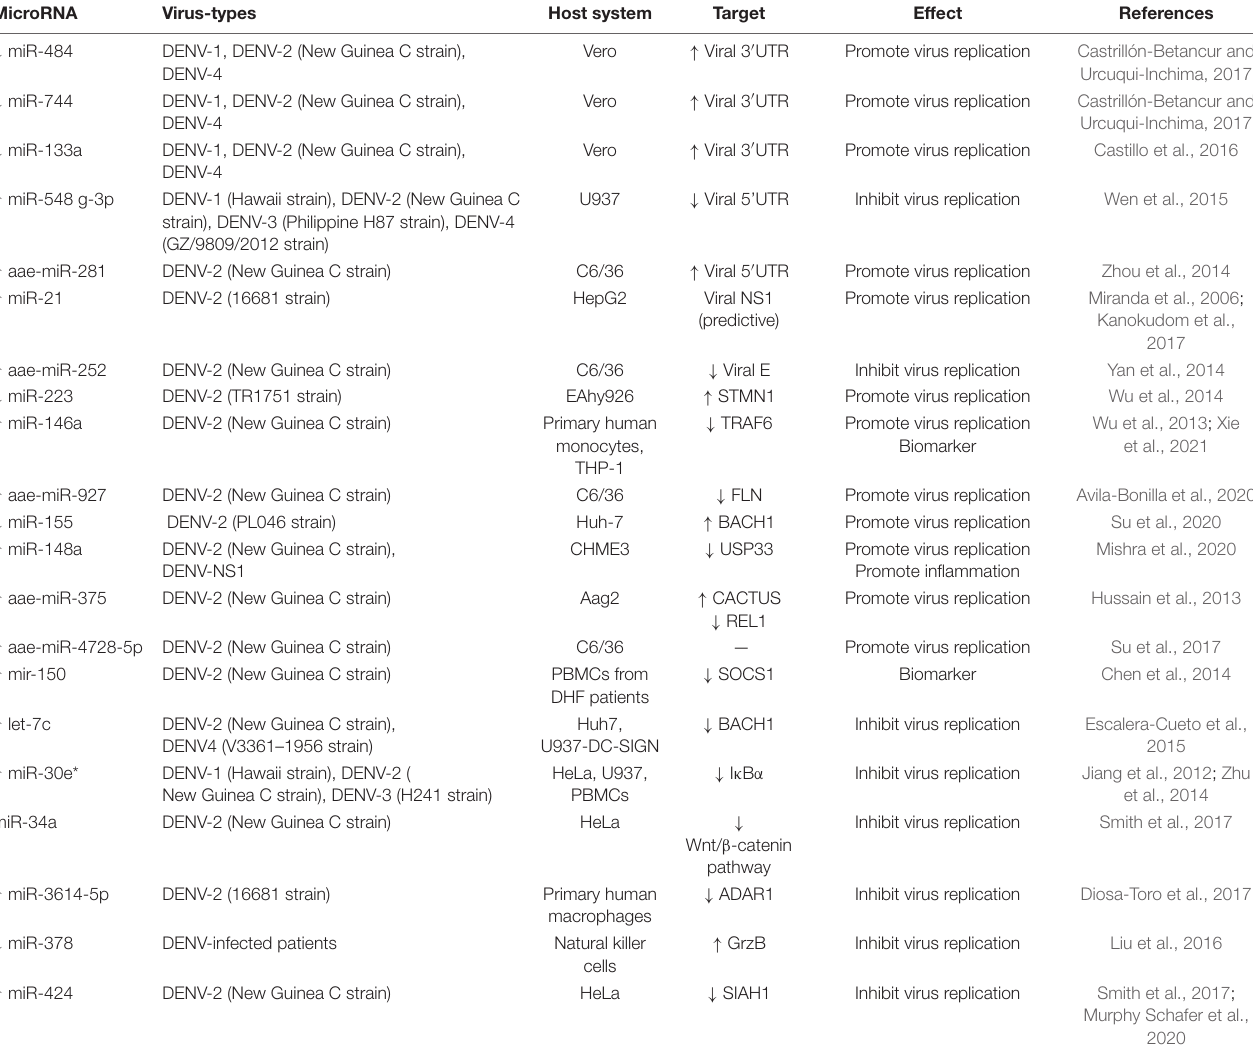
TABLE 1 | Differentially expressed miRNAs involved in DENV infection and their targets a